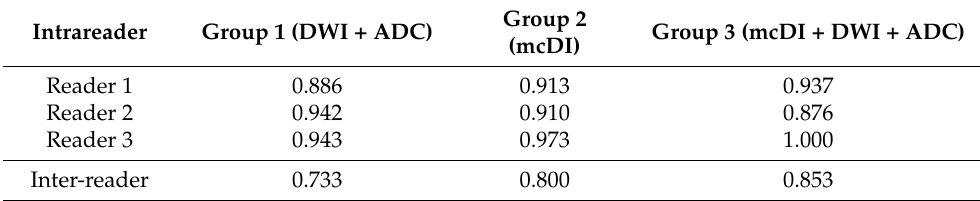
Table 1. Inter- and inter-reader agreement 1